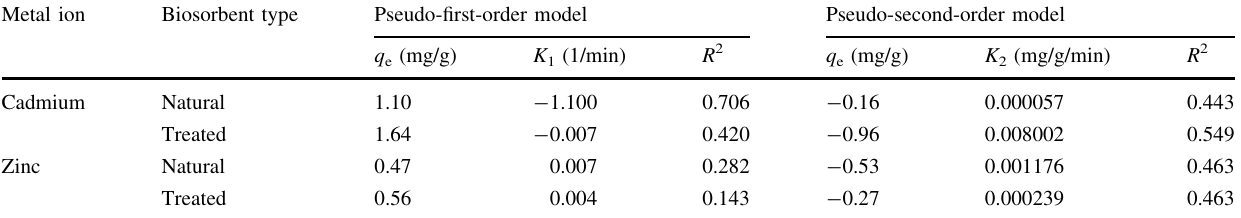
Table 2 Pseudo-first and second order model